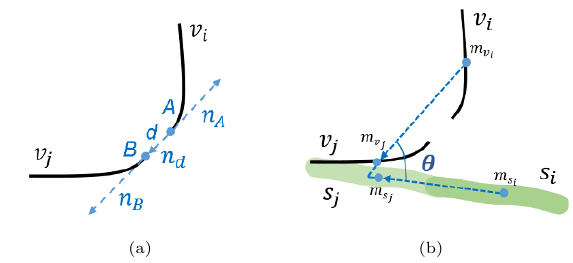
Fig. 4 Continuity measure for a pair of line segments v i and v j . (a) Two line segments with strong continuity in terms of C line . (b) Two line segments with weak continuity in terms of C user . Edge direction is decided by the angle between line segments and the matching stroke